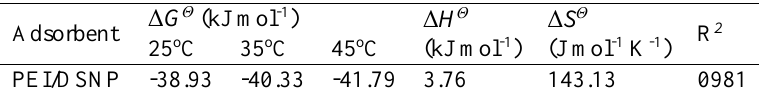
Table 5. Calculated Gibbs free adsorption energy, enthalpy and entropy for Pb 2+ adsorption on PEI/DSNPat 25, 35 and 45